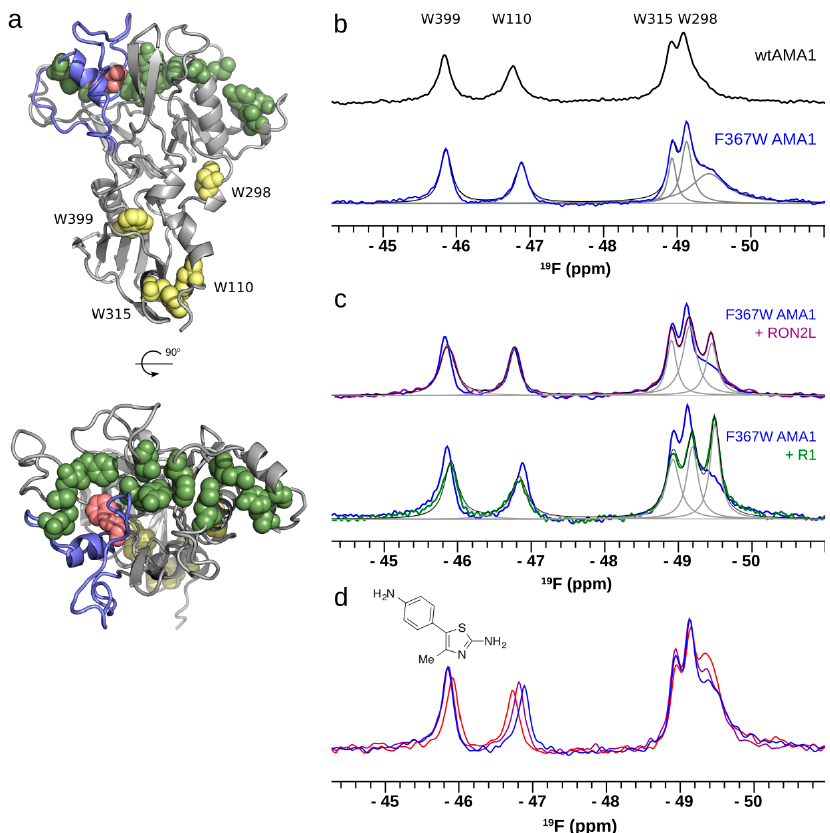
Figure 3. 19 F-NMR as a probe of ligand binding to AMA1. ( a ) The structure of AMA1 (domains I and II; PDB id 2Z8V) showing the RON2 binding site (green), the DII loop (blue), the site of the introduced 5-F-Trp 367 (red) and the four native Trp residues (yellow) ( b ) 19 F-NMR spectrum of 5-F-Trp labelled F367W AMA1 (blue) contains signals from the four Trp residues in wt AMA1 (black; assigned by mutagenesis), plus an additional broad signal attributed to the introduced 5-F-Trp367. Deconvolution of the spectrum as the sum of five Lorentzian signals is shown (grey); ( c ) Addition of the peptide ligands RON2L (purple) or R1 (green) causes the 5-F-Trp367 resonance to become sharp; ( d ) A series of amino-thiophene fragments at 0 (blue), 1 (purple) and 3 mM (red) bind to AMA1 and cause concentration-dependent sharpening of the 5-F-Trp367 resonance. Samples contained ~100 μ M 5-F-Trp F367W AMA1 in 20 mM sodium phosphate, pH 7.4, and spectra were recorded at 25 °C and a 19 F frequency of 564 MHz without 1 H decoupling [52].